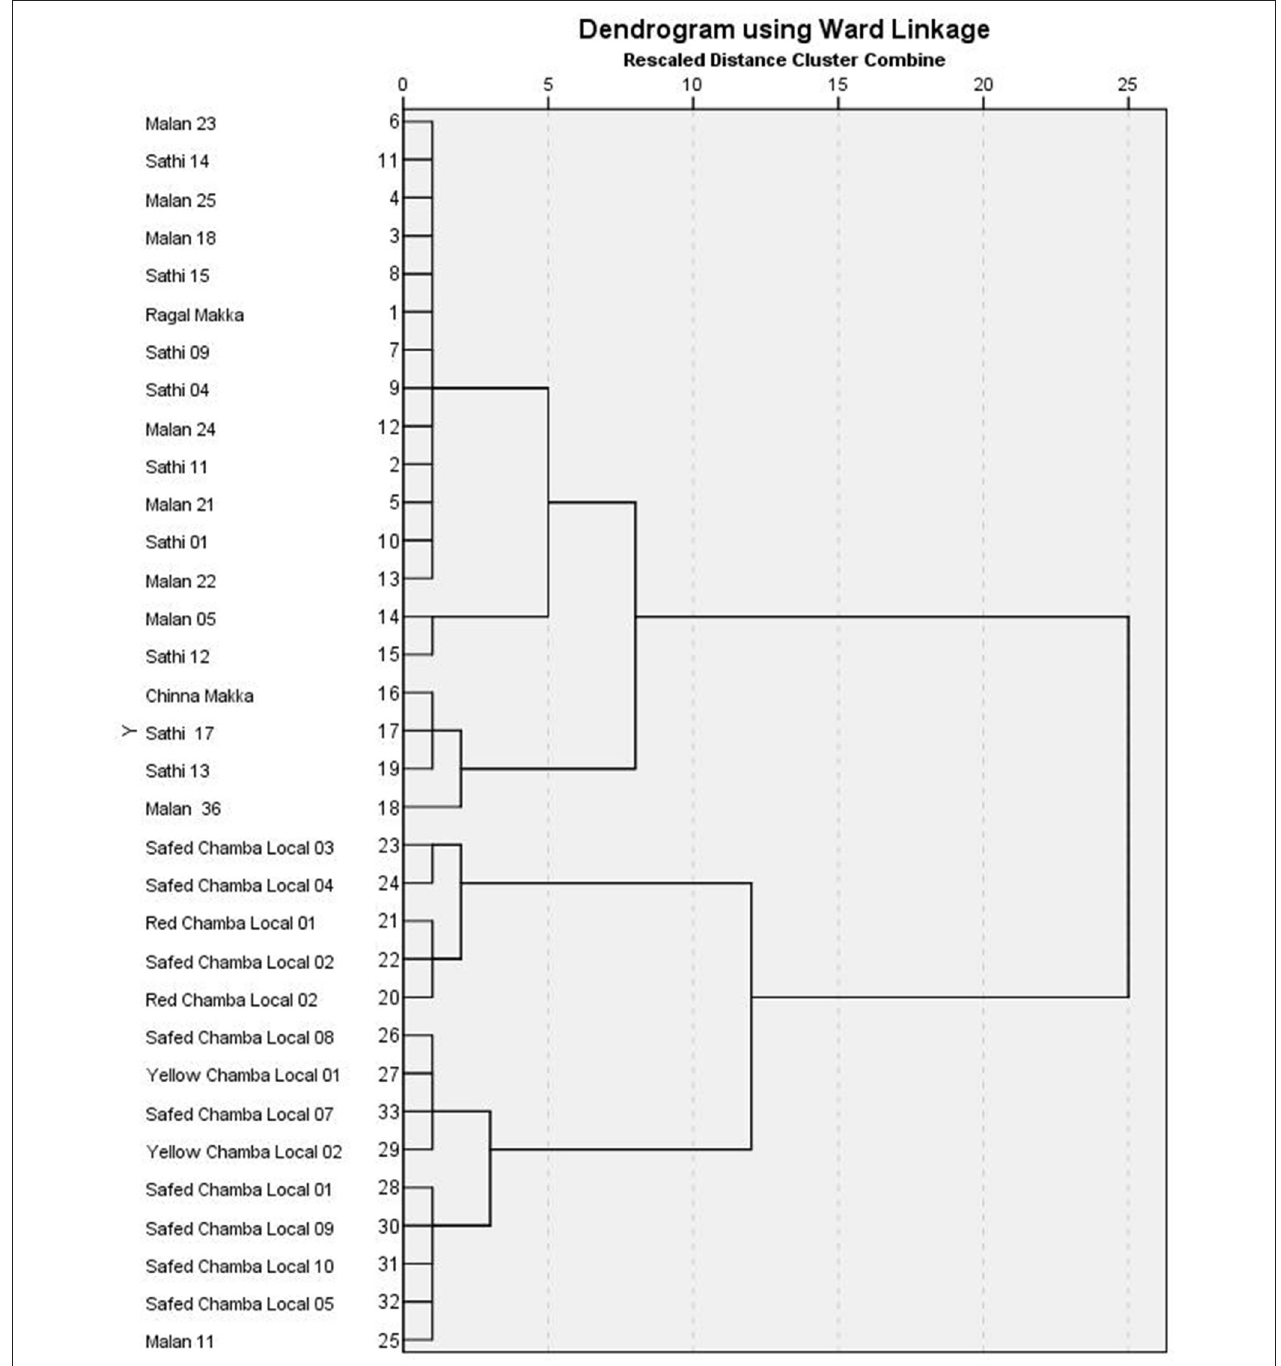
FIGURE 1 | Scree plot for principal component analysis (PCA) in native maize germplasm.